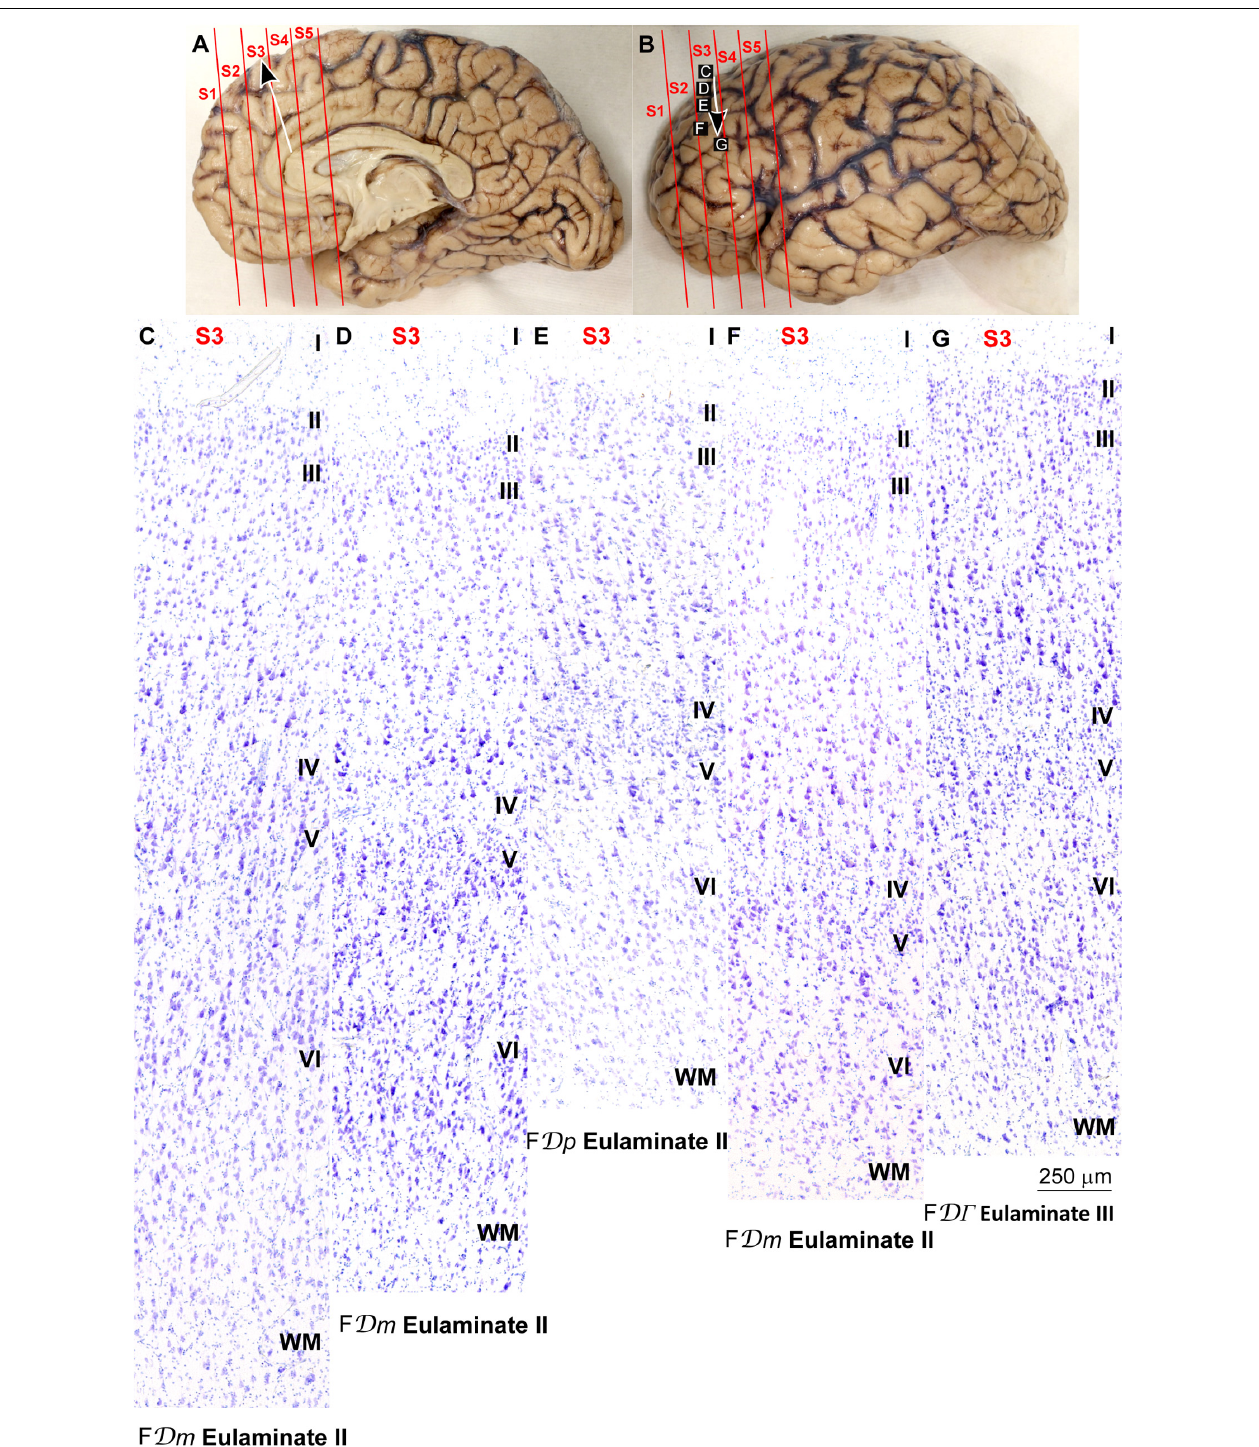
FIGURE 5 | Systematic and gradual variation of laminar structure across areas of the parahippocampal trend in the human prefrontal cortex: Dorsolateral prefrontal areas. (A,B) , Medial (A) and lateral (B) views of the left hemisphere from the brain (case HCD): red lines show the planes of separation of coronal slabs; black and white arrows indicate laminar differentiation along the parahippocampal trend. (C–G) Micrographs of the dorsolateral prefrontal cortex in Nissl stained sections at the levels indicated in (B) ; the areas according to the Atlas of von Economo and Koskinas (1925/2008) and the cortical type are indicated below each micrograph; see the text for description of laminar features. S1, S2, S3, S4, S5, indicate coronal slabs from anterior to posterior; WM, white matter. Roman numerals indicate cortical layers. Calibration bar in (G) applies to (C–G) .